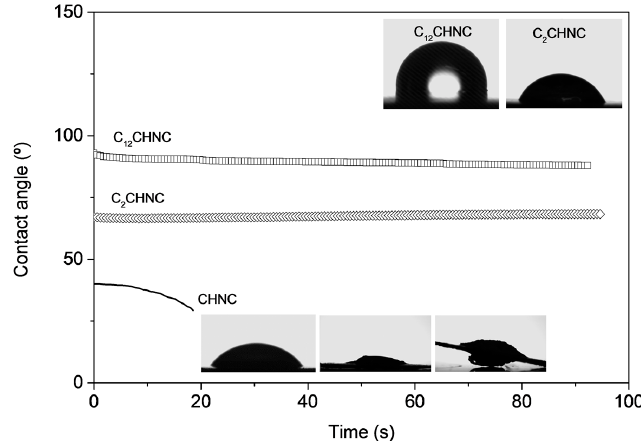
Figure 5. Dynamic water contact angle of CHNC and functionalized C 2 CHNC and C 12 CHNC and image of the water drop on the surface of the respective pellet.